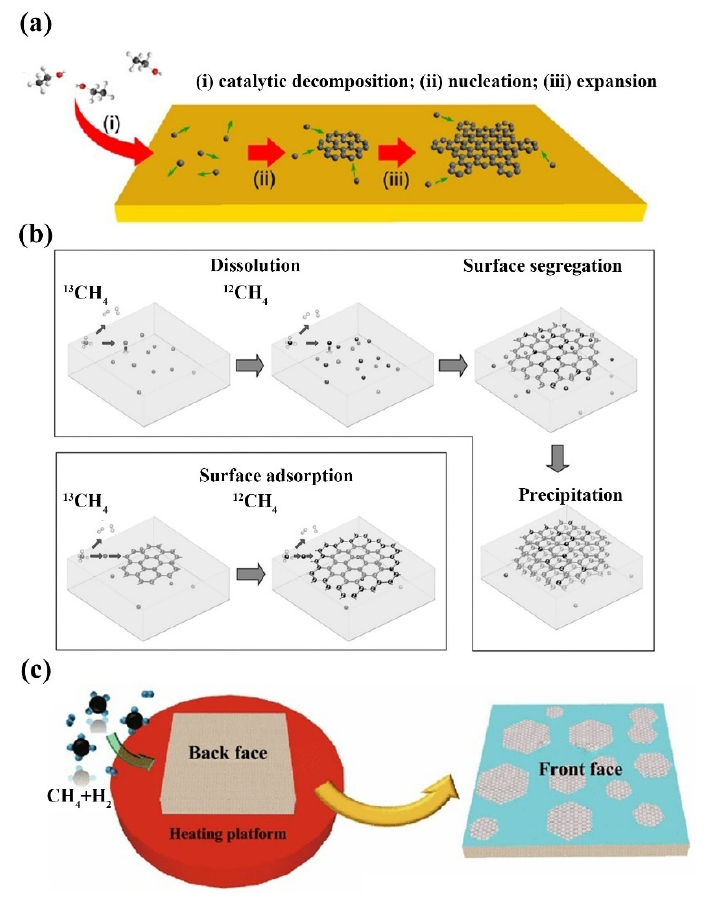
Figure 2. ( a ) Schematic of the initial state of the growth of graphene on copper from ethanol. Reprinted with permission from Ref. [51]. Copyright 2013, American Chemical Society. ( b ) Schematic diagram of the possible distribution of C isotopes in graphene films based on different growth mechanisms of CVD (surface segregation/surface adsorption). Reprinted with permission from Ref. [52]. Copyright 2016, Wiley Online Library. ( c ) Schematic of graphene growing on an inverted silicon surface. Reprinted with permission from Ref. [56]. Copyright 2018, Springer Nature.